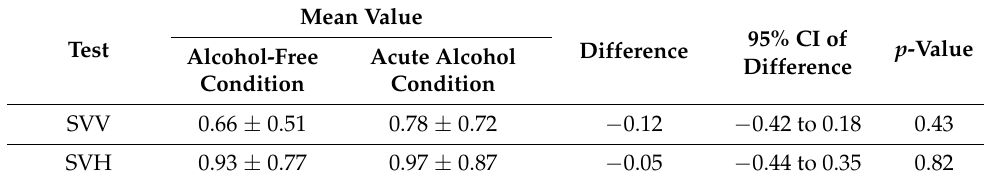
Table 3. Changes in the perception of verticality in alcohol-free and acute alcohol conditions. Mean Value 95% CI of p -Value Alcohol-Free Test Difference Acute Alcohol Difference Condition Condition SVV 0.66 ± 0.51 0.78 ± 0.72 − 0.12 − 0.42 to 0.18 0.43 SVH 0.93 ± 0.77 0.97 ± 0.87 − 0.05 − 0.44 to 0.35